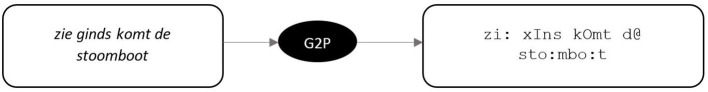
Grapheme-to-phoneme conversion of the Dutch sentence Zie ginds komt de stoomboot (‘see the steamboat over there’).